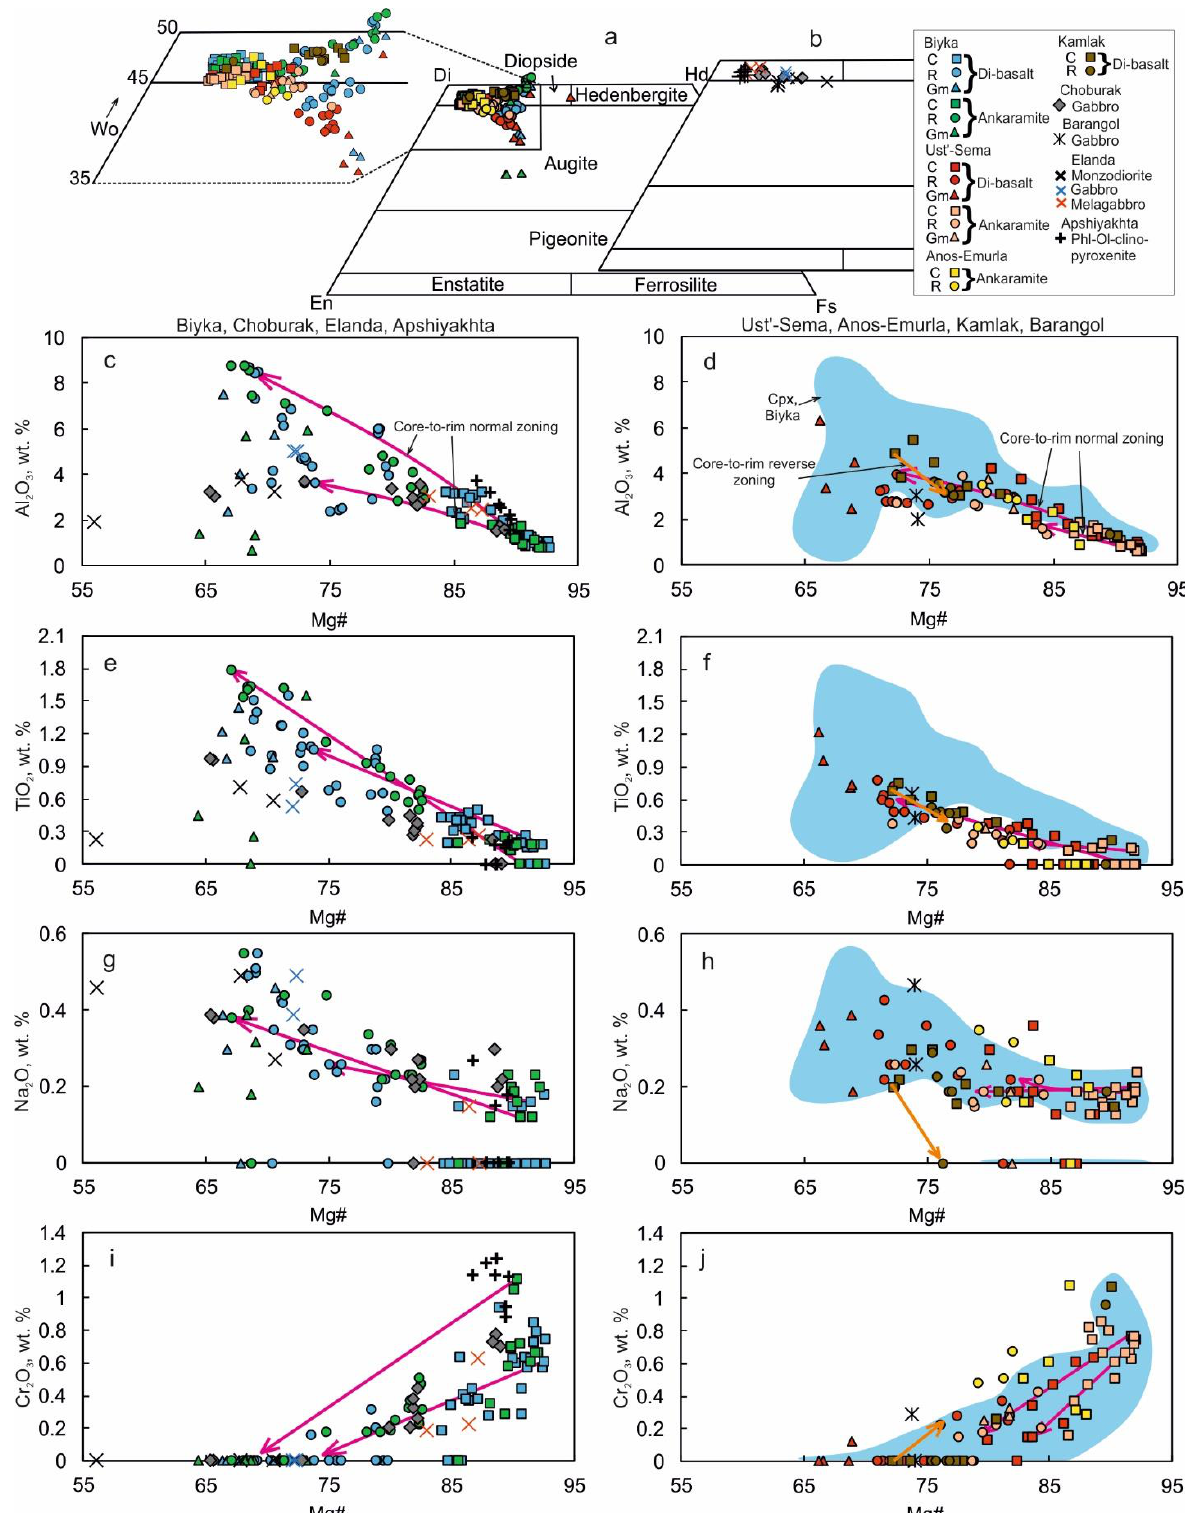
Figure 7. Compositions of clinopyroxene from the Ust’-Sema Formation and Barangol Complex rocks, Gorny Altai: ( a , b ) classification diagram [27] for pyroxenes from the Ust’-Sema Formation ( a ) and the Barangol Complex ( b ) [27]; ( c – j ) variations in Mg# with Al 2 O 3 , TiO 2 , Na 2 O, and Cr 2 O 3 for clinopyroxene. For zoning clinopyroxene phenocrysts: C—core; R—rim; Gm—from the groundmass. Trends show typical cases of normal (purple) and reverse (orange) zoning.